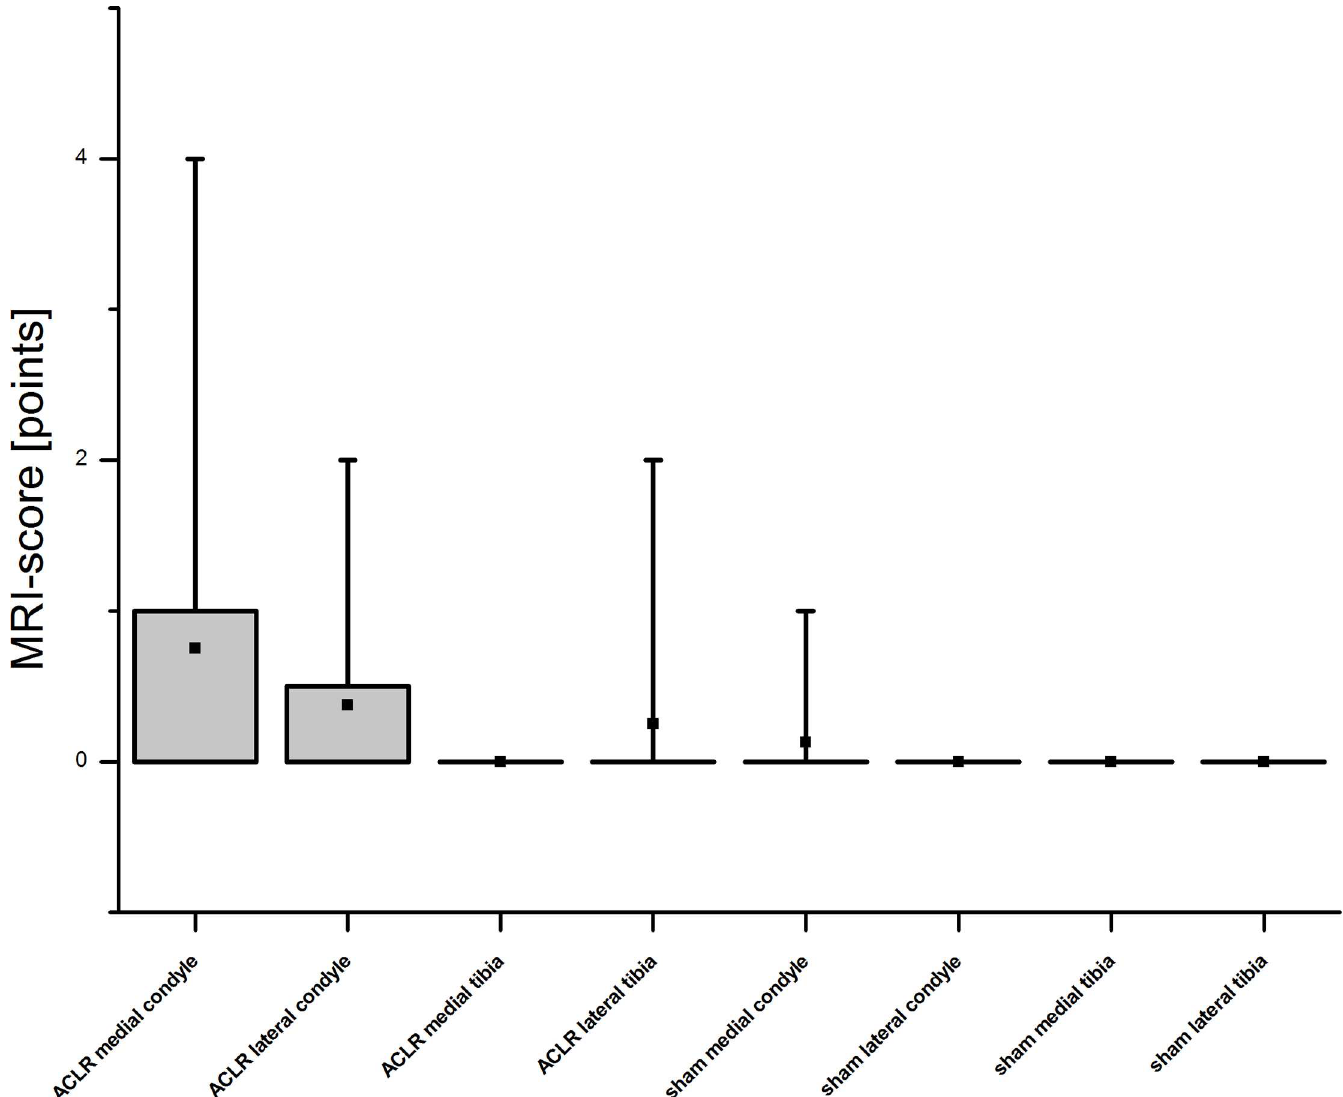
Fig 7. MRI scoring. MRI scans of eight Go¨ttingen Minipigs were scored accordingto an adaptedWORMS-score. The score ranges from 0–22 points. The results showed that in the samples, either from ACLR or sham knee joints, no or only minor changes were visible in the MRI